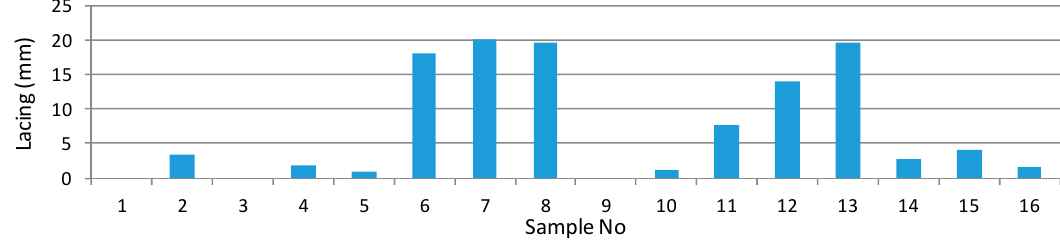
Figure 11. Lacing amount (mm) for individual samples.